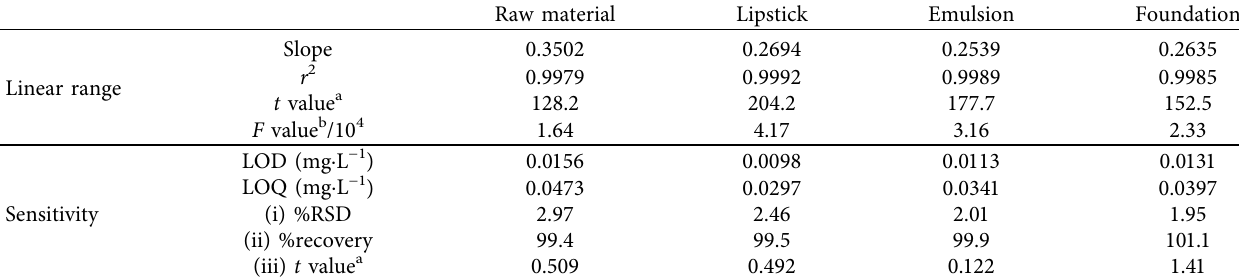
Table 2: Linearity and sensitivity parameters for all cosmetic matrices.